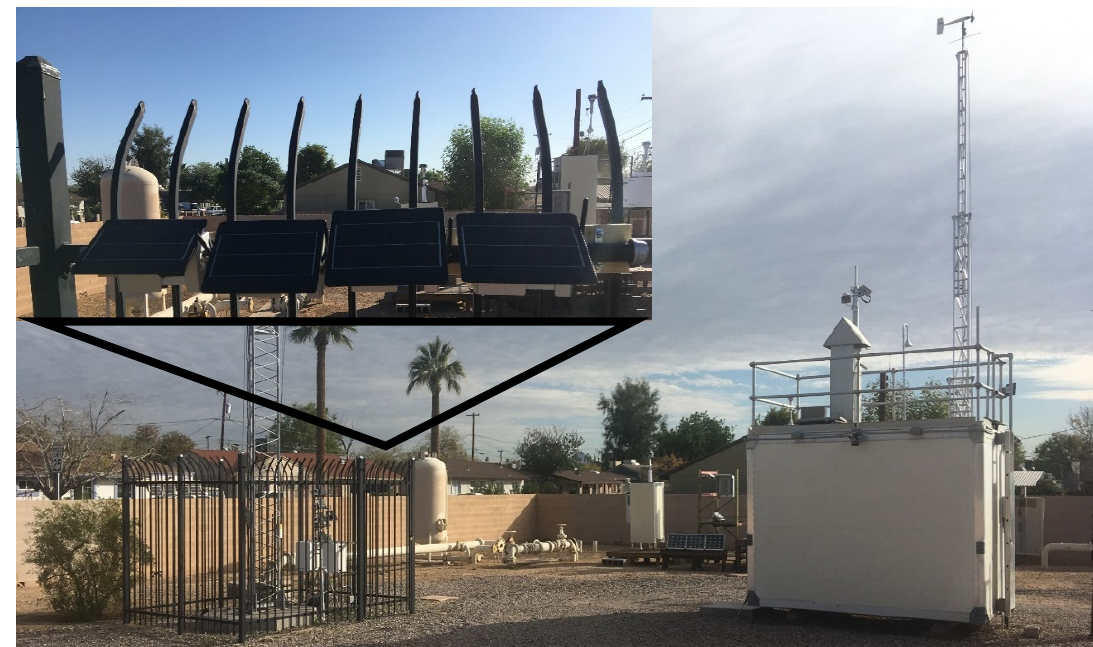
Figure 1. West Phoenix Air Monitoring Site with the Clarity Node-S LCS.